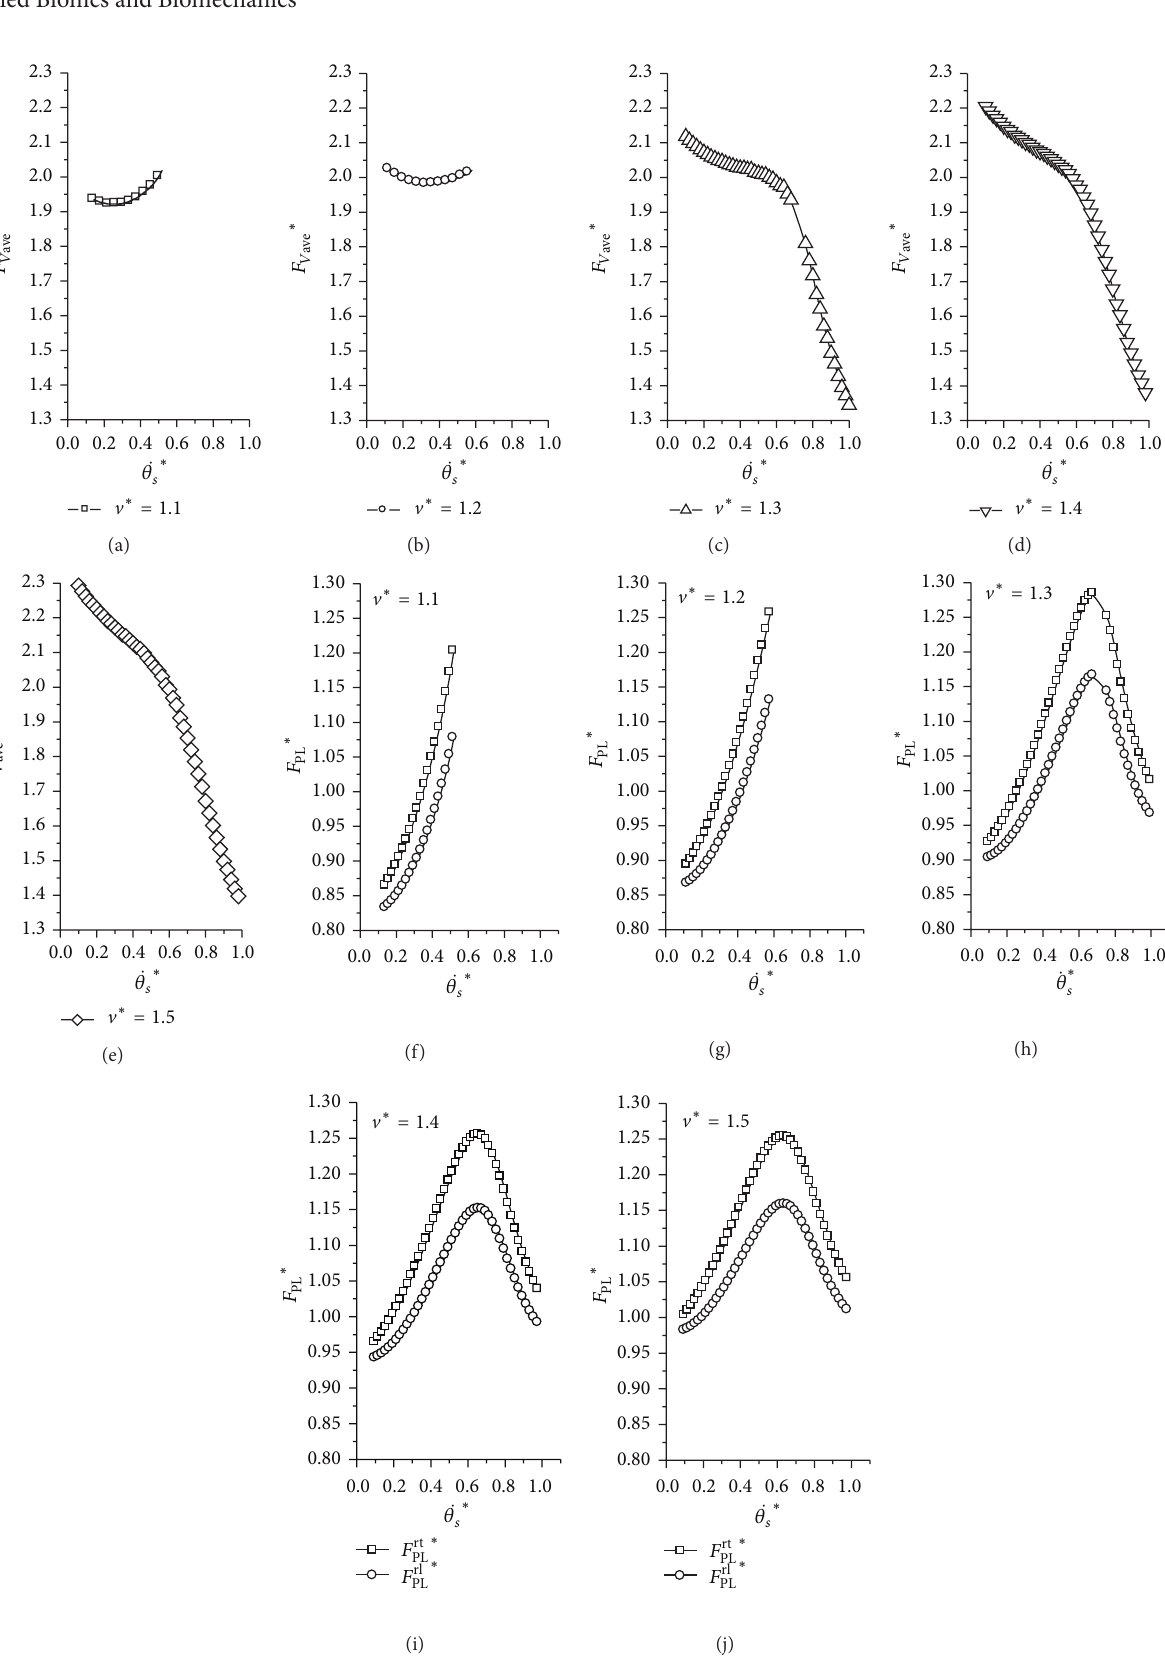
Figure 4: The average vertical force, peak leg force of the rear trailing leg, and the rear leading leg for different dimensionless horizontal speeds. (a)–(e) are the average dimensionless vertical forces for different horizontal velocities, and (f)–(j) are the dimensionless peak leg forces of the rear trailing and the rear leading for different horizontal velocities. Initial conditions: 𝑦 ∗ 𝑠 = 1 , 𝜇 = 0.05 , 𝑝 = 1.0 , and 𝑘 𝑎 = 1.0